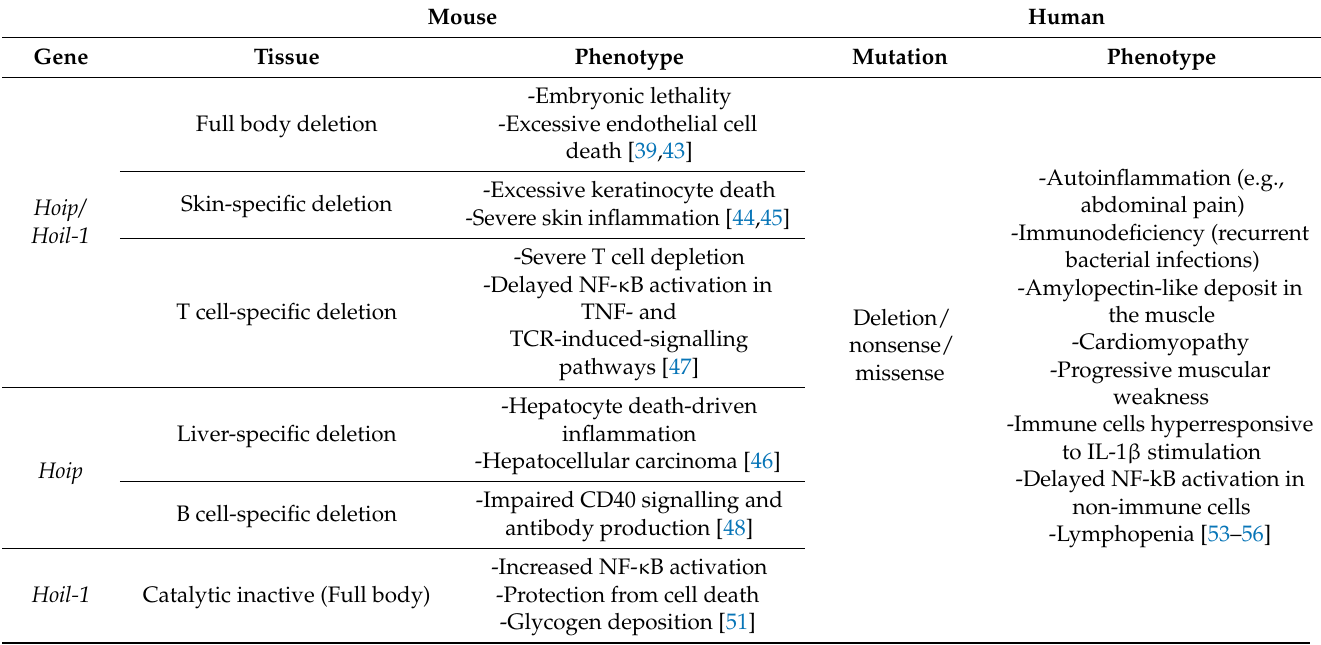
Table 1. Overview of the pathological consequences of the deletion or mutation of the indicated genes in mice and human